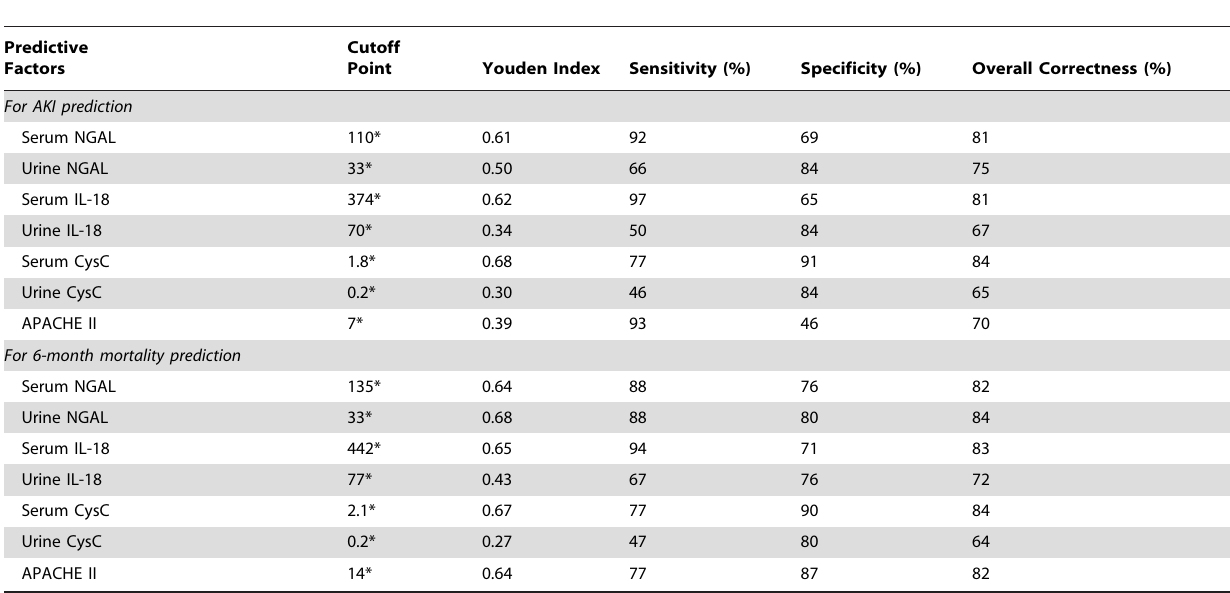
Table 6. Predictions of the biomarkers and APACHE II on the first of CCU admission in predicting AKI and 6-month